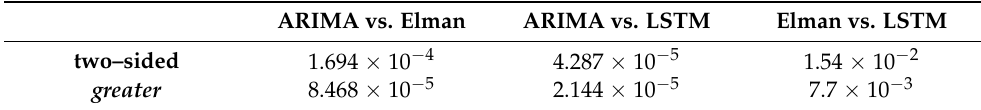
Table 3. Diebold–Mariano